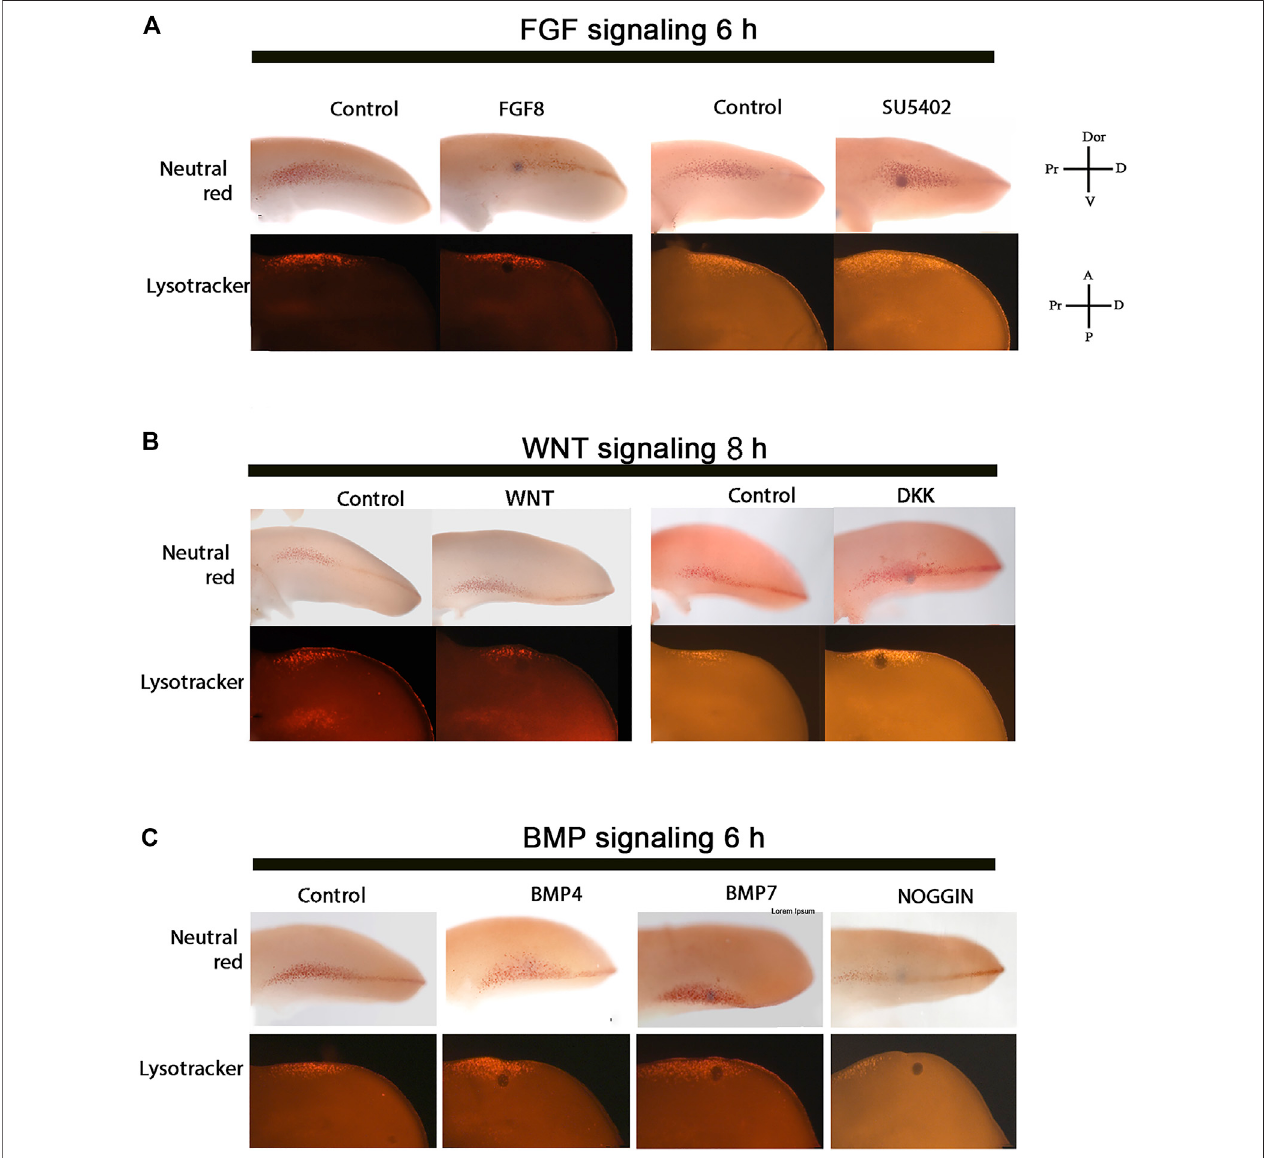
FIGURE3| ControlofPCDintheANZbyFGF,WNT,andBMPsignaling.ThecelldeathpatternwasevaluatedintheANZatlimbdevelopingstage24HHafterFGF, WNT, and BMP signaling treatments. (A) FGF8 treatment for 6 h did not modify the cell death pattern but inhibiting FGF signaling resulted in the promotion of PCD. (B) WNT3A treatment for 8 h did not alter the cell death pattern, but DKK-treatment to inhibit Wnt signaling induced cell death after 8 h. (C) BMP4- or BMP7- treatment for 6 h promoted cell death, whereas NOGGIN inhibited cell death after 6 h of treatment. Notice that the minimum time to trigger cell death in the ANZ is 6 h after inhibiting FGF or activating BMP signaling, whereas DKK needed 8 h to promote cell death. The images at the top of each line correspond to samples stained with Neutral Red, while the images at the bottom are stained with Lysotracker. The axis showed in A can be used for B and C.